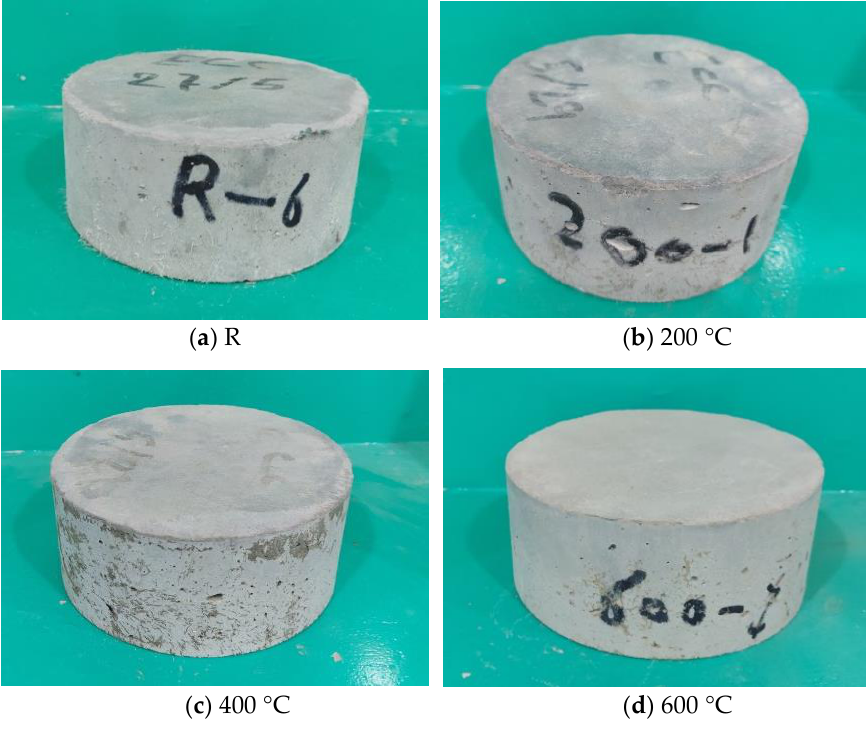
Figure 7. Impact test specimens subjected to different temperatures.